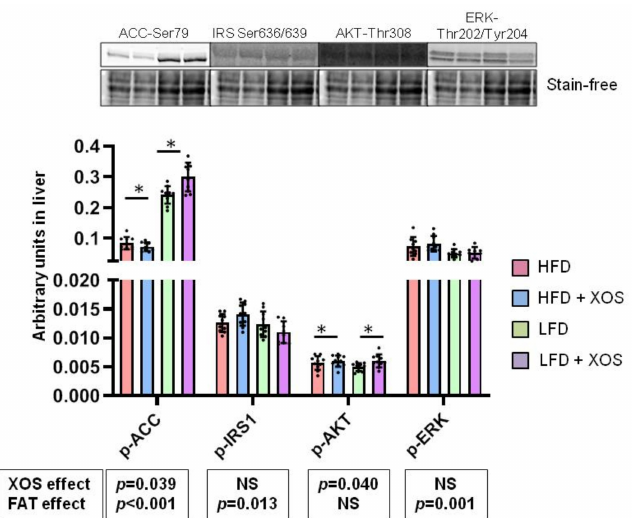
Figure 3. The phosphorylation levels of ACC, IRS1, AKT and ERK in liver. n = 8–10/group. The graph shows the quantification of the proteins by Western blot. The black dots in the bars show individual data points. Above the graph examples of the blot images are shown. The effects of XOS and dietary fat (FAT) on each phosphorylated protein are indicated in the boxes below the graphs. NS denotes non-significant effect. The effects of XOS were further verified with Mann Whitney U test, and * indicates statistically significant ( p < 0.05) difference between the HFD or LFD group and the corresponding XOS-supplemented group as determined by Mann Whitney U